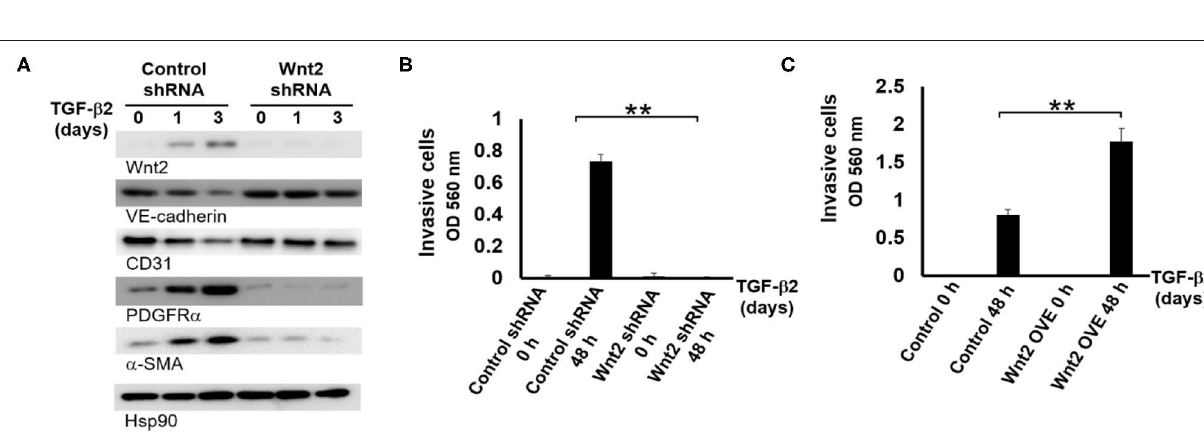
FIGURE 3 | Wnt ligand expression is upregulated during TGF- β -mediated EndMT. (A) RT-PCR analysis of Wnt2, Wnt4, Wnt10B, and Wnt11 mRNA expression during TGF- β -mediated EndMT for different time courses. Each value represents the mean ± SD of three separate experiments. n = 3, * P < 0.05, ** P < 0.01. (B) WB analysis of Wnt ligand protein expression during TGF- β -mediated EndMT. WCLs collected from cells treated with TGF- β 2 for 0, 1, and 3 days were subjected to WB analysis. Hsp90 protein expression is used as a loading control.